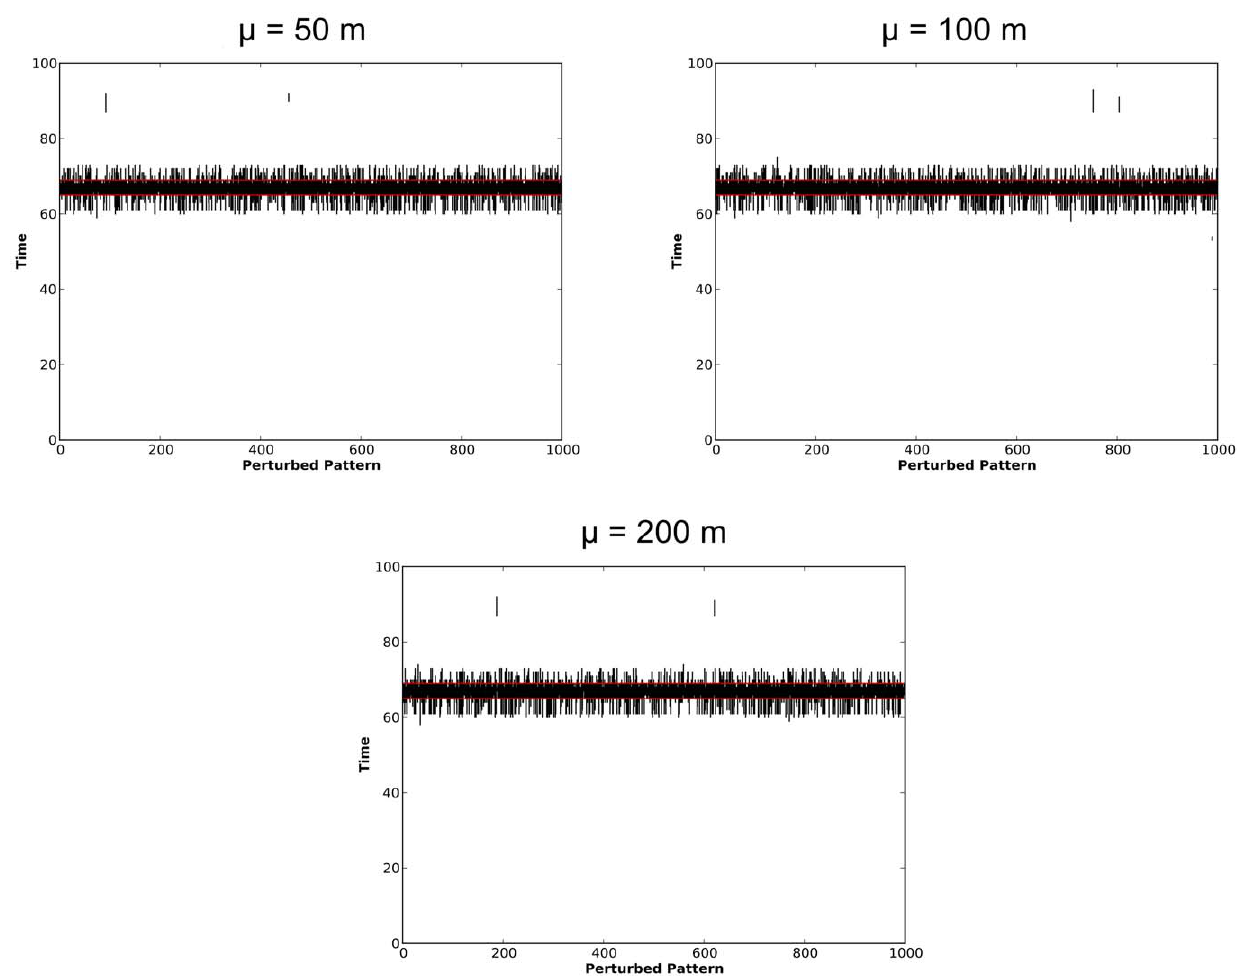
Figure 11. Plots of the duration of MLCs identified within the Mesa crime data using the STPSS. The duration of the MLC for the original dataset is denoted using horizontal red lines. MLCs from perturbed versions of the same dataset are shown as black vertical lines.